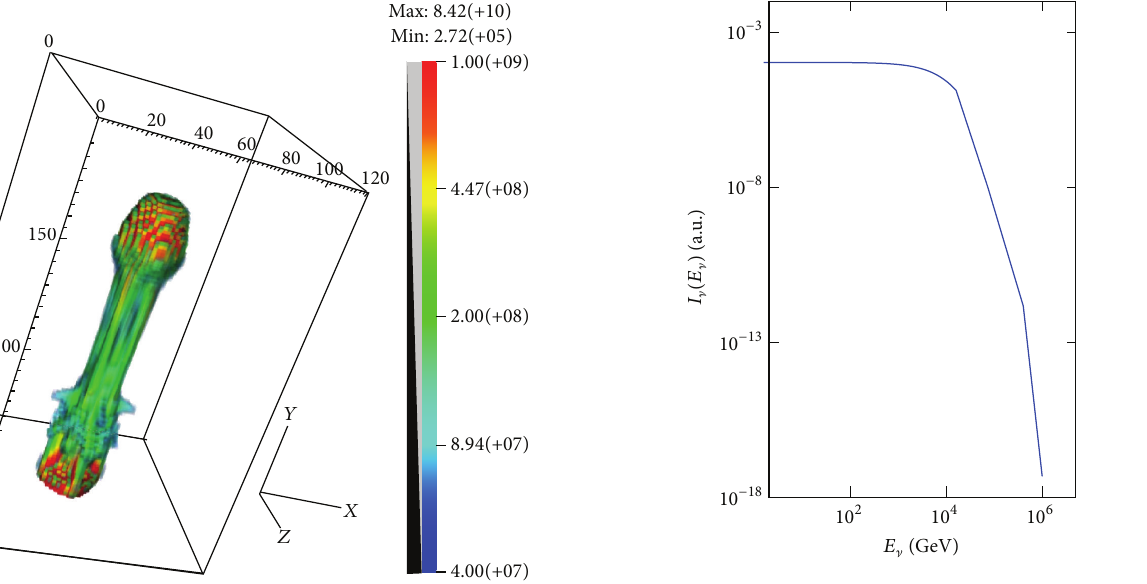
Figure 3: A plot of the jet density roughly halfway into the simulation. We can see the jet beam advancing along a narrow path through the ambient medium, kept together by the magnetic toroidal field component. This confined jet is then a suitable site for increased high energy 𝛾 -ray and neutrino emission/production, due to maintaining extreme conditions along the jet length.